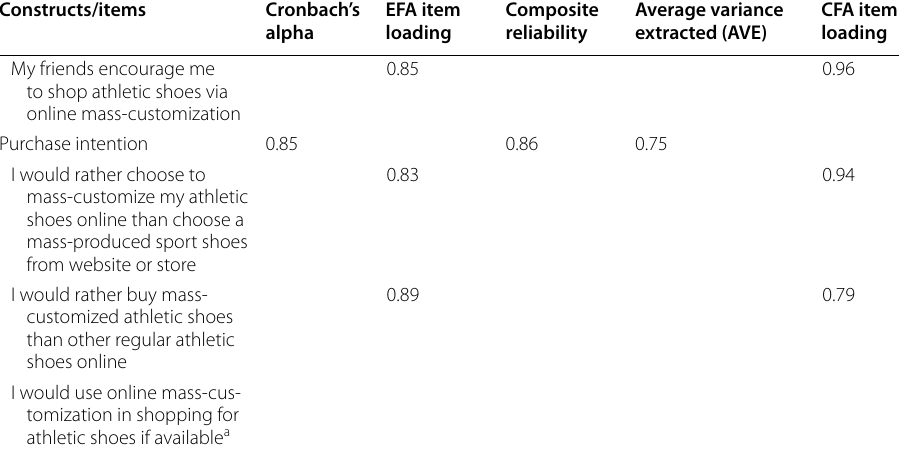
Table 3 The comparison between square roots of AVEs and correlations